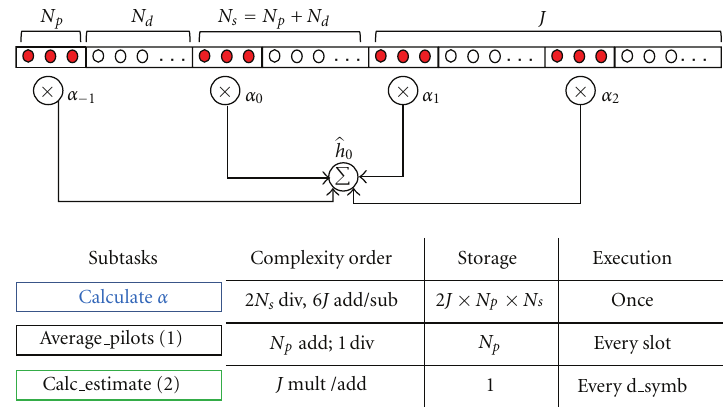
Figure 1: WMSA details and